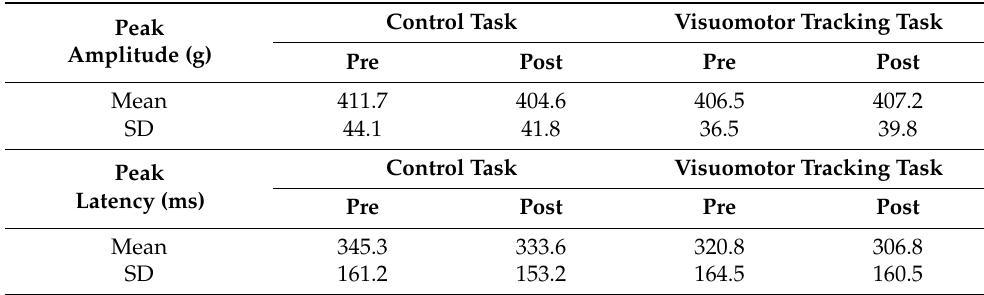
Table 2. Peak amplitudes and peak latencies of grip force before the control and visuomotor track- ing